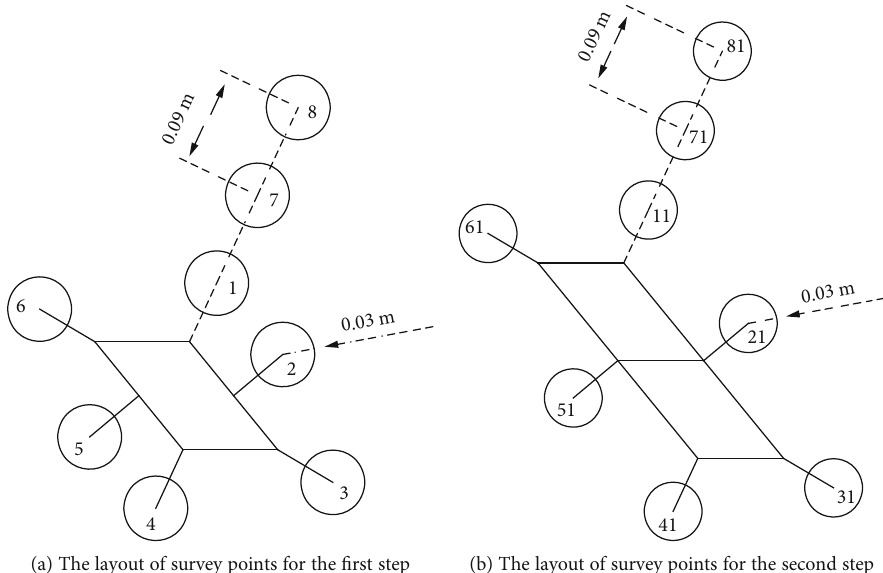
Figure 8: The layout of survey points on the surrounding rock and overlying strata in the PFC model for the fi rst excavation step and the second excavation